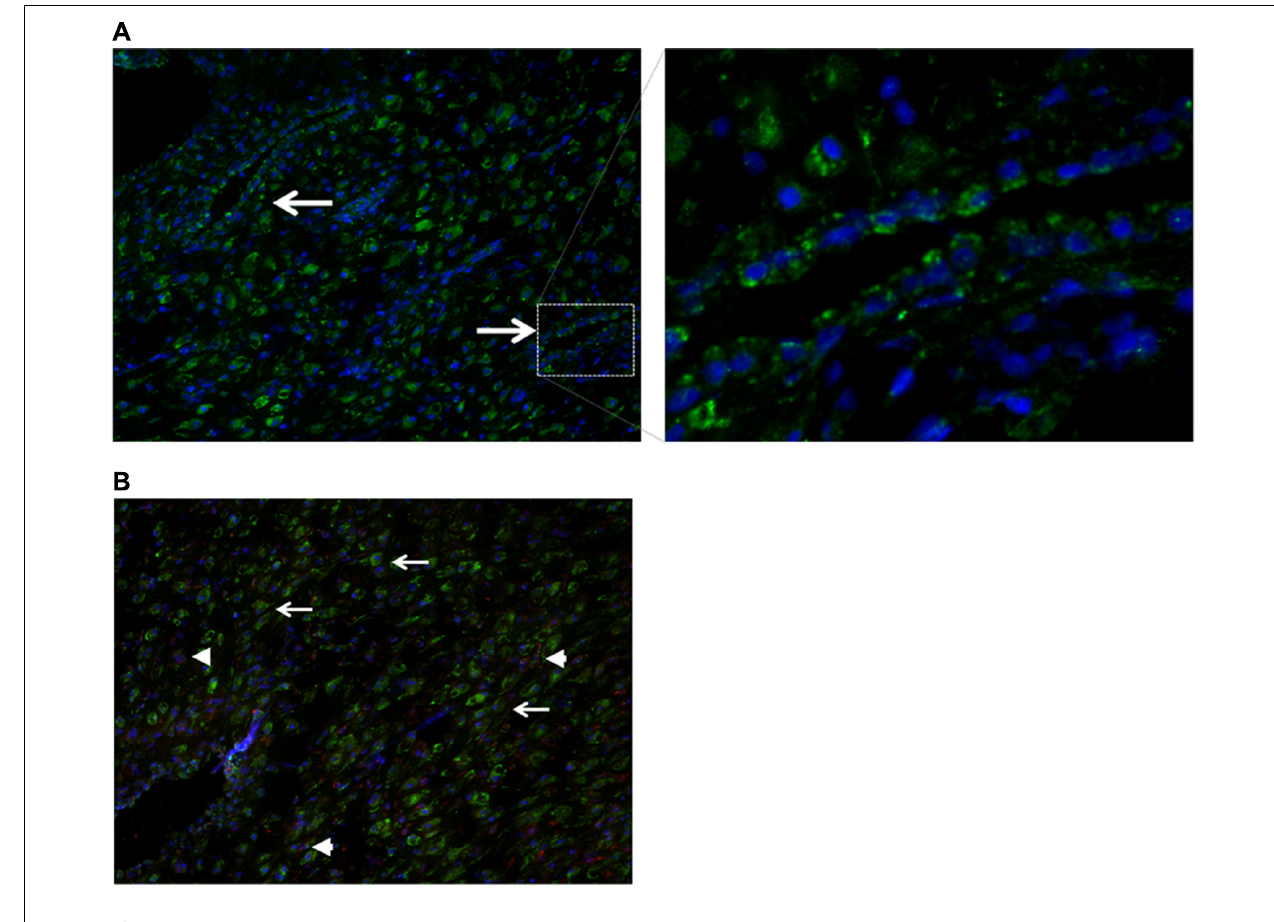
FIGURE 4 | Localization of Nodal in human first trimester decidua. (A) Immunohistochemistry showing expression of Nodal (green) in epithelial glandular cells. (B) Localization of Nodal (green) in placental derived